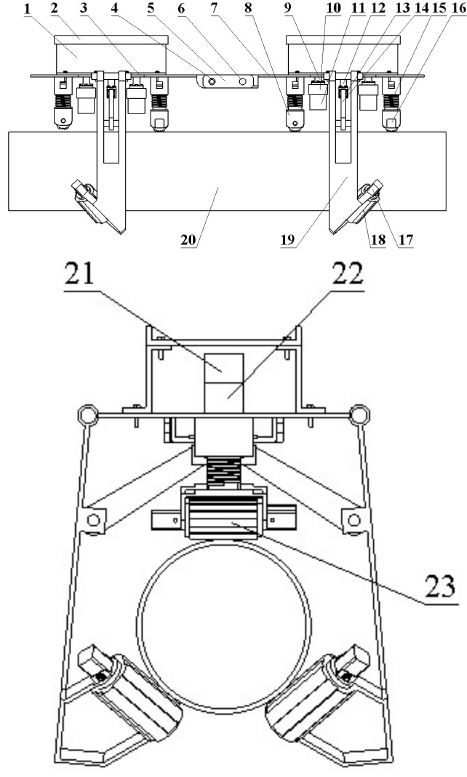
Figure 1. The two-dimensional model of the pipe-climbing